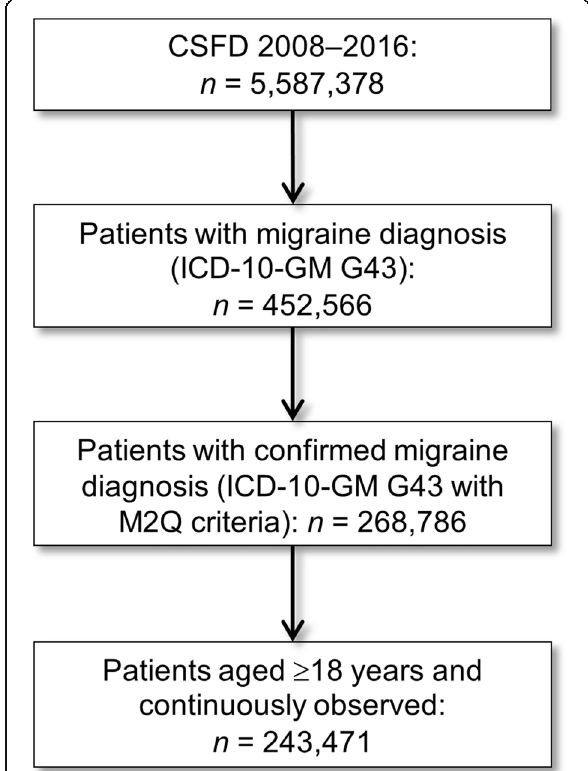
Fig. 2 Flow chart of the identification of eligible patients with migraine in the German Company Sickness Fund database (CSFD) 2008 to 2016. ICD-10-GM International Classification of Diseases, 10th revision, German modification; M2Q ‘ Mindestens zwei [2] Quartale ’ , which translates to ‘ at least two [2] quarters